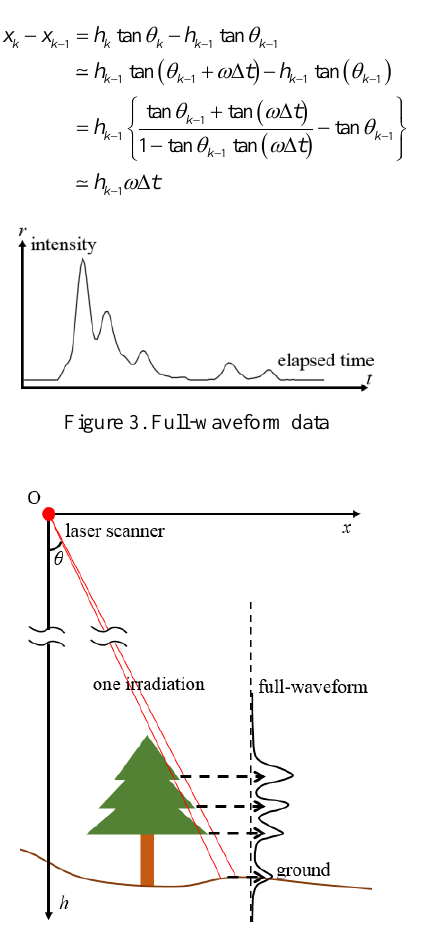
Figure 4. x - h coordinates, reflection intensity and target